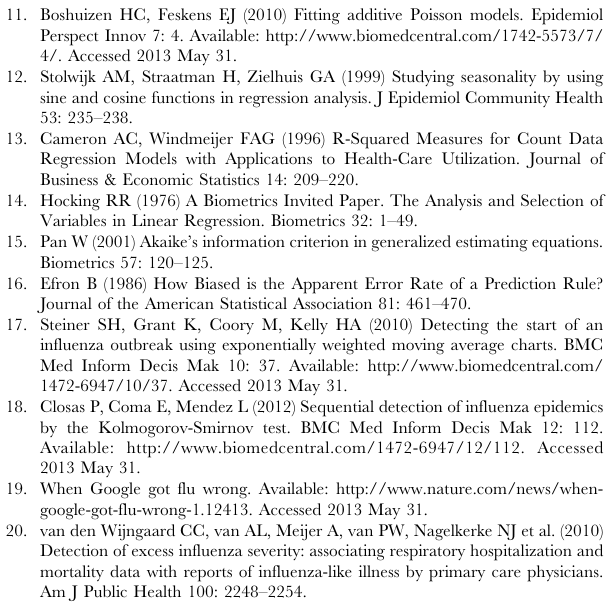
Prediction Model covariates Percentage of ICU admissions with respiratory infection One current week + one week before + two weeks before + three week weeks before + Cosine and Sine term with k=1 + Cosine ahead and Sine term with k=2 + Chronological week number Same as one week ahead Two weeks ahead Three Same as one week ahead, except ‘Percentage of ICU weeks admissions with respiratory infection four and five weeks ahead before’ is also